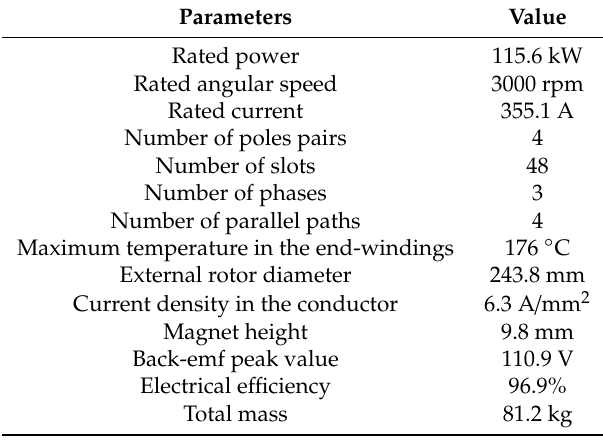
Table 5. Problem 2: best rated power motor and best solution of the optimization